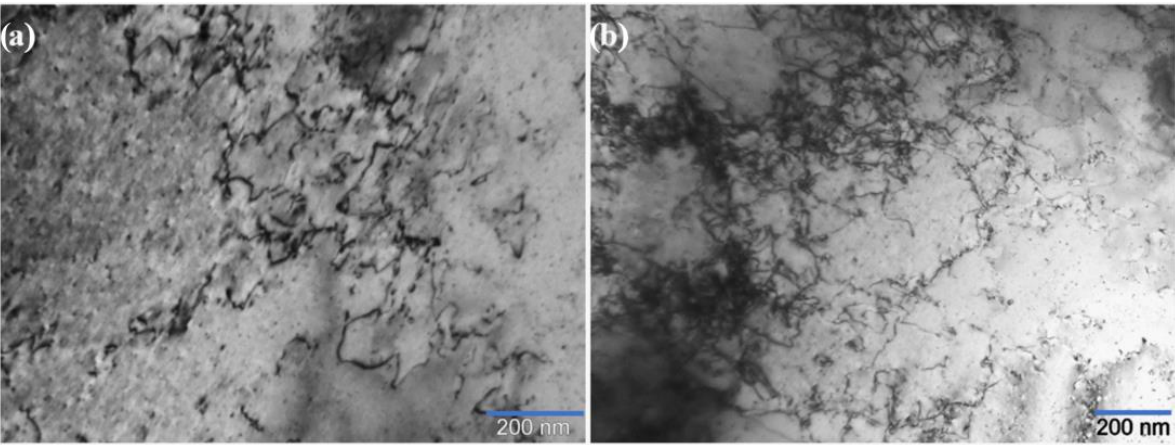
Figure 3. TEM images obtained ( a ) on the surface of undeformed spheres, ( b ) in the contact region. Plastic deformation causes the generation and accumulation of dislocations; they appear roughly uniformly distributed with a slight tendency to form a cell structure, as typical of pure metals during dynamic recovery, which occurs during deformation